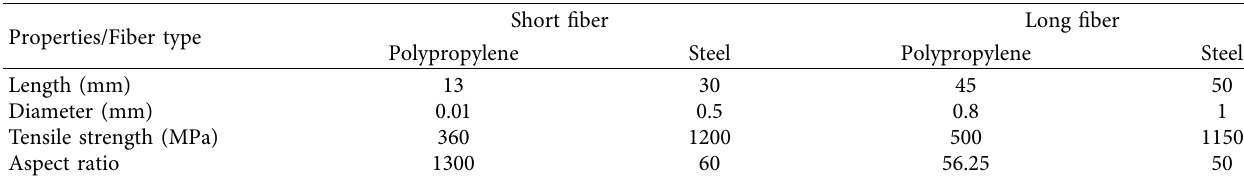
Figure 1: Raw materials: (a) silica fume, (b) GGBFS, (c) fy ash, (d) fne aggregate, (e) coarse aggregate, (f) superplasticizer, (g) sodium silicate, and (h) sodium hydroxide. Table 2: Information about the properties of fbers.